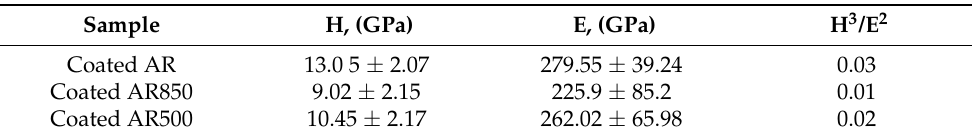
Table 4. Hardness (H), elastic modulus (E), and their power-up ratios of TiN/TiO 2 coatings deposited on AR and EBM Ti6Al4V alloy.